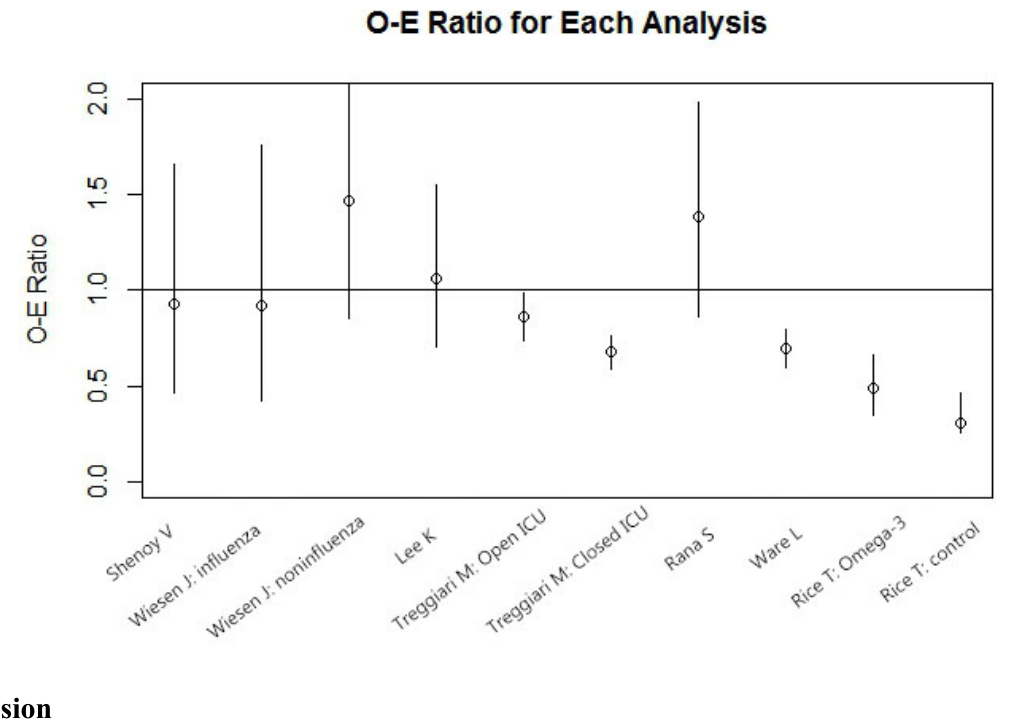
( p = 0.007) (Figure 3). To Confirm, we also employed the random model and found similar result: RR = 0.69, 95% CI (0.51, 0.93) ( p = 0.01). Figure 5. Heterogeneity Analysis: Observed/Expected Ratio (O/E Ratio) of Acute Lung Injury Studies: The vertical axis shows the O/E Ratio. The O/E Ratio of both Omega-3 group (0.48, 95% CI: 0.34–0.67) and control group (0.30, 95% CI: 0.19–0.46) in Rice T. et al . [13] study are far below 1, which indicate that the patients in the Rice T. et al . study are in significantly more severe condition, but have significantly lower